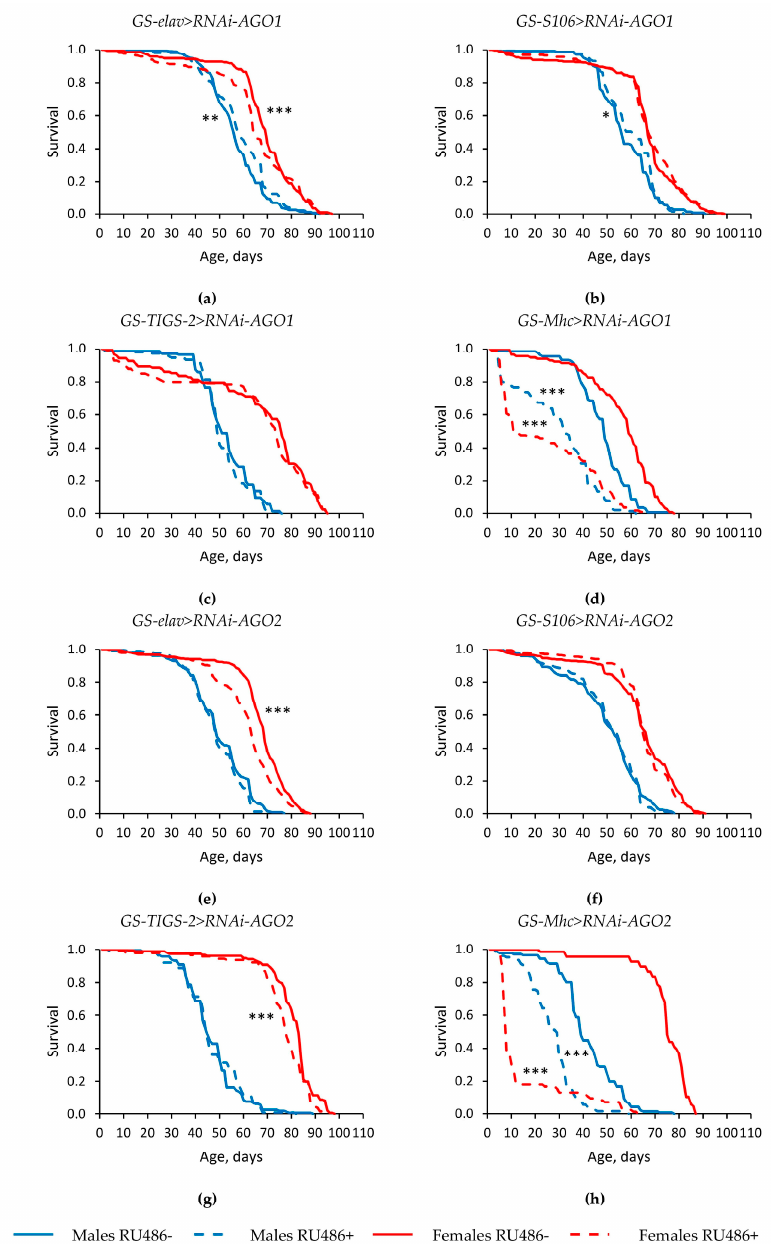
Figure 1. Influence of AGO1 ( a – d ) and AGO2 ( e – h ) knockdown in the nervous system ( a , e ) (two replicates combined), fat body ( b , f ) (two replicates combined), guts ( c , g ), muscles ( d , h ) on the survival of Drosophila melanogaster . Differences between survival curves of flies with Argonaute genes’ knockdown (RU486+) and without knockdown (RU486-) are statistically significant with * p < 0.05, ** p < 0.01, *** p < 0.001 (Kolmogorov–Smirnov test).